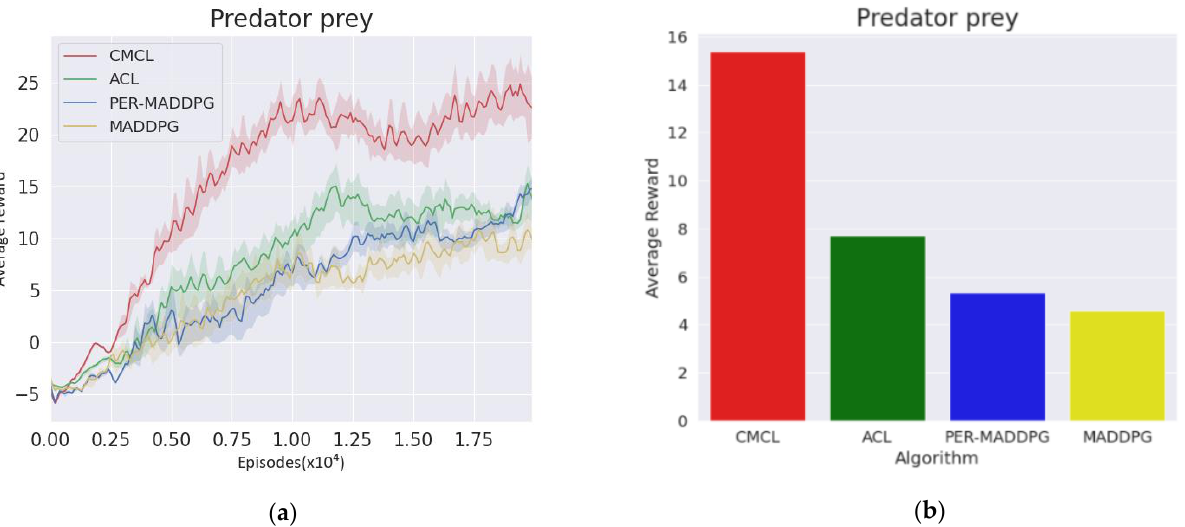
Figure 12. Representation diagram of agents in cooperative environment. ( a ) Episode reward achieved in adversarial environment; ( b ) the average reward obtained by the four algorithms in the adversarial environment.